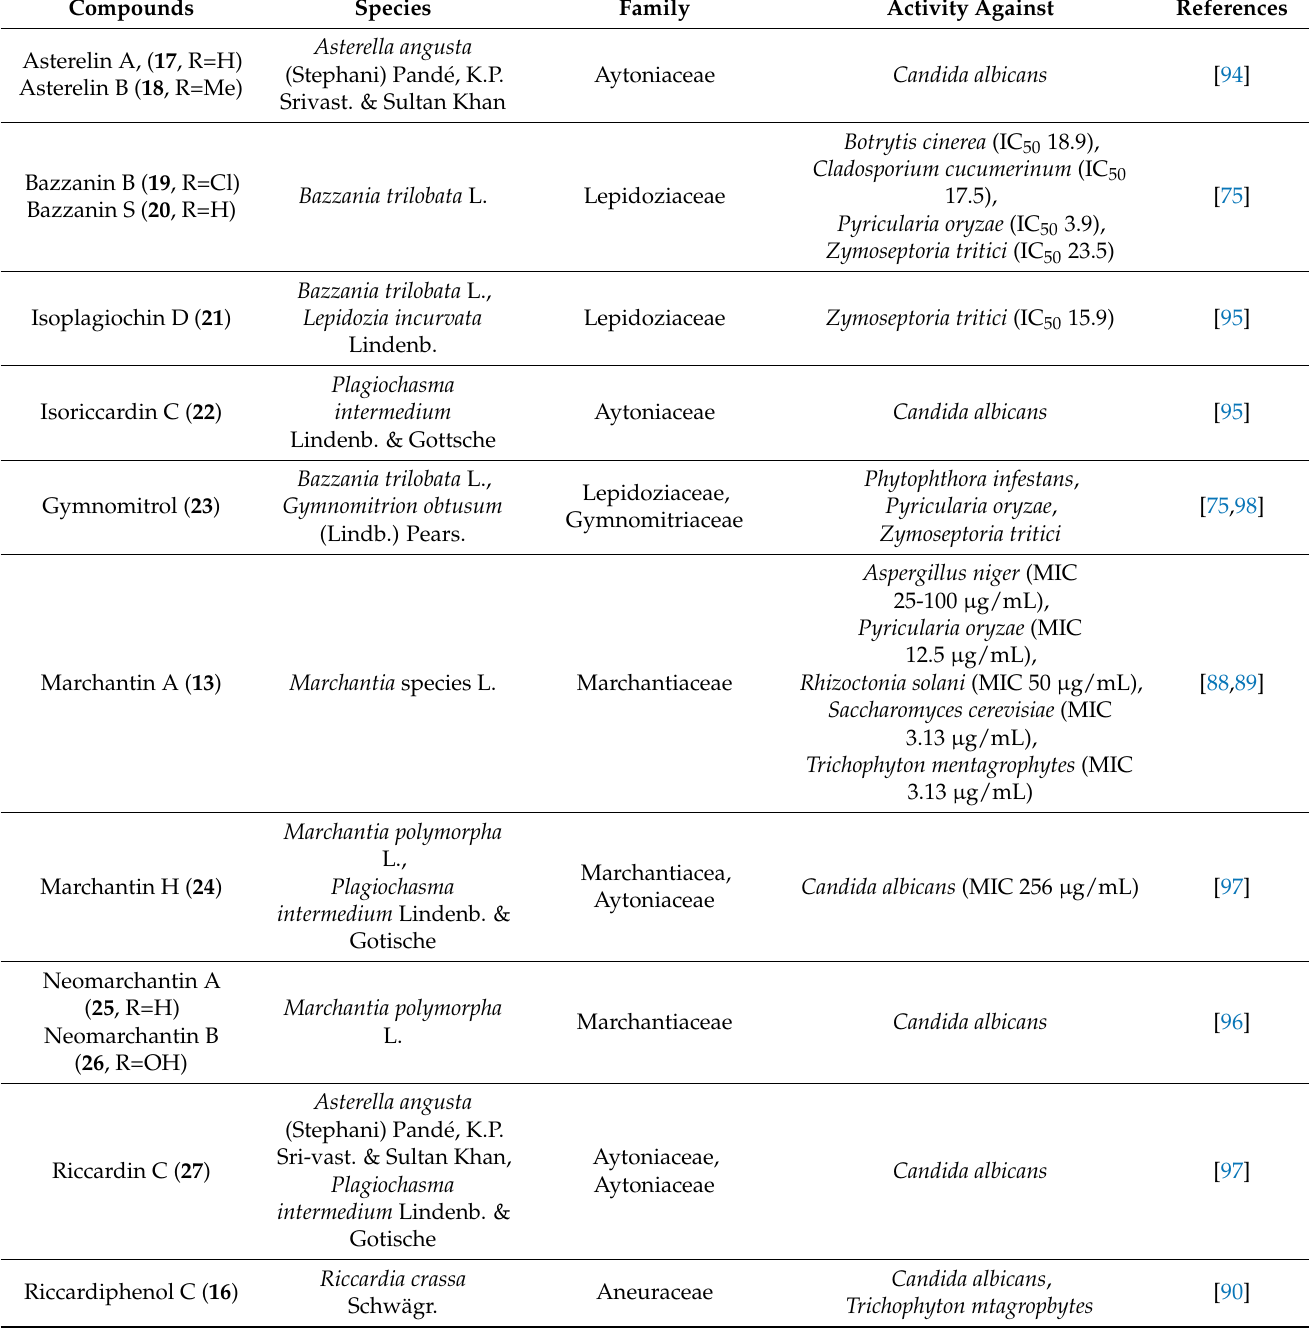
Table 5. Antifungal activities of compounds isolated from